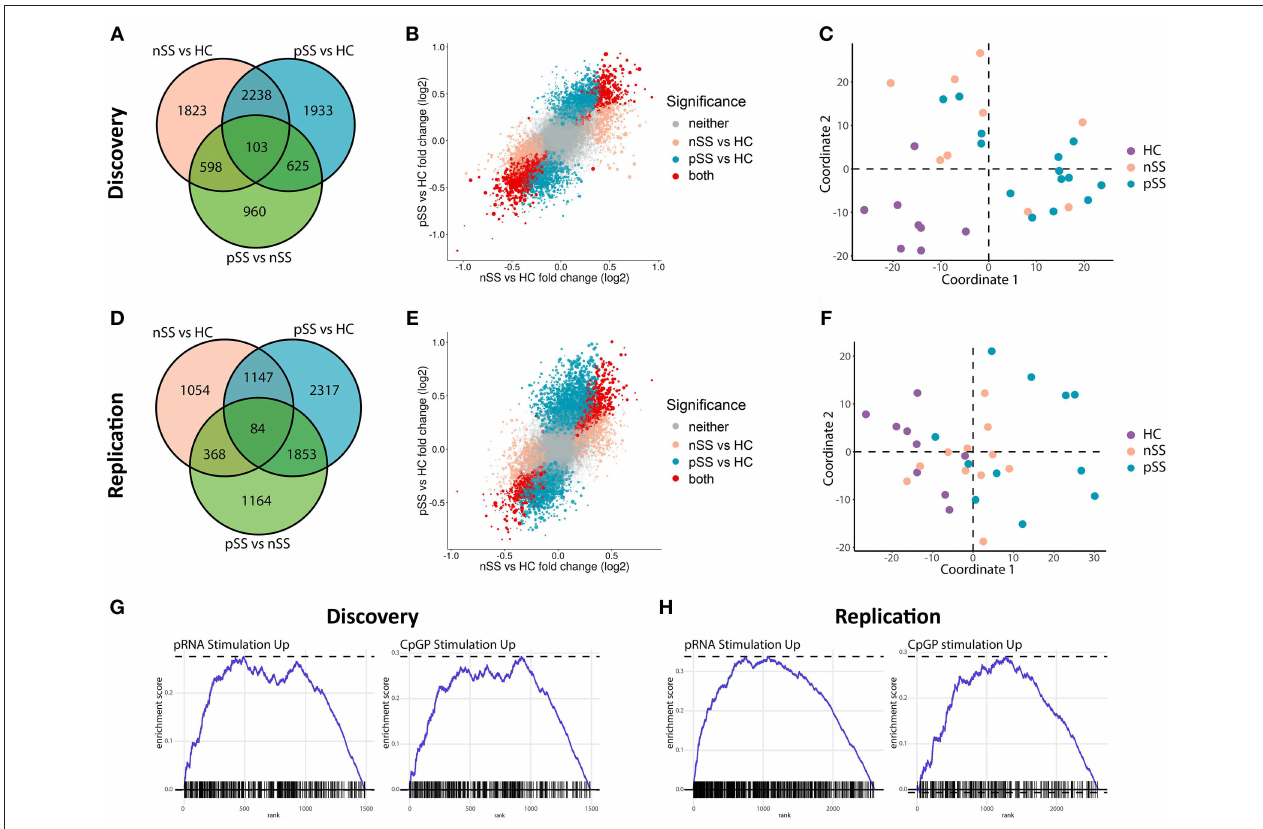
FIGURE 1 | Circulating pDCs from pSS and nSS patients are transcriptionally altered and display gene-expression patterns similar to TLR-stimulated pDCs. pDCs were isolated from peripheral blood of two independent cohorts; discovery and replication (each n = 31). RNA sequencing was performed independently for both cohorts. Genes differentially expressed (nominal p -value p < 0.05) between any of the three groups from the discovery cohort were identified (A) . The association between gene expression in pSS vs. HC and nSS vs. HC was plotted; each gene is represented as a dot, with the color reflecting the comparison in which it is significantly differentially expressed and the size reflecting the expression level (larger dots depict genes with higher expression) (B) . Multi-dimensional scaling was used to plot the dissimilarities between the donors from the discovery cohort based on the expression of all differentially expressed genes, taking into account all comparisons (C) . The same analyses were performed on RNA sequencing data from the replication cohort (D–F) . Using gene-set enrichment analysis, the differentially-expressed upregulated genes in pSS pDCs as compared to HC were compared to those of in vitro stimulated pDCs from a published study (29). There was a significant overlap in upregulated genes between pDCs stimulated with either pRNA (TLR7 ligand) and CPG-P (TLR9 ligand) and pSS pDCs (all FDR-corrected p < 0.05; G,H